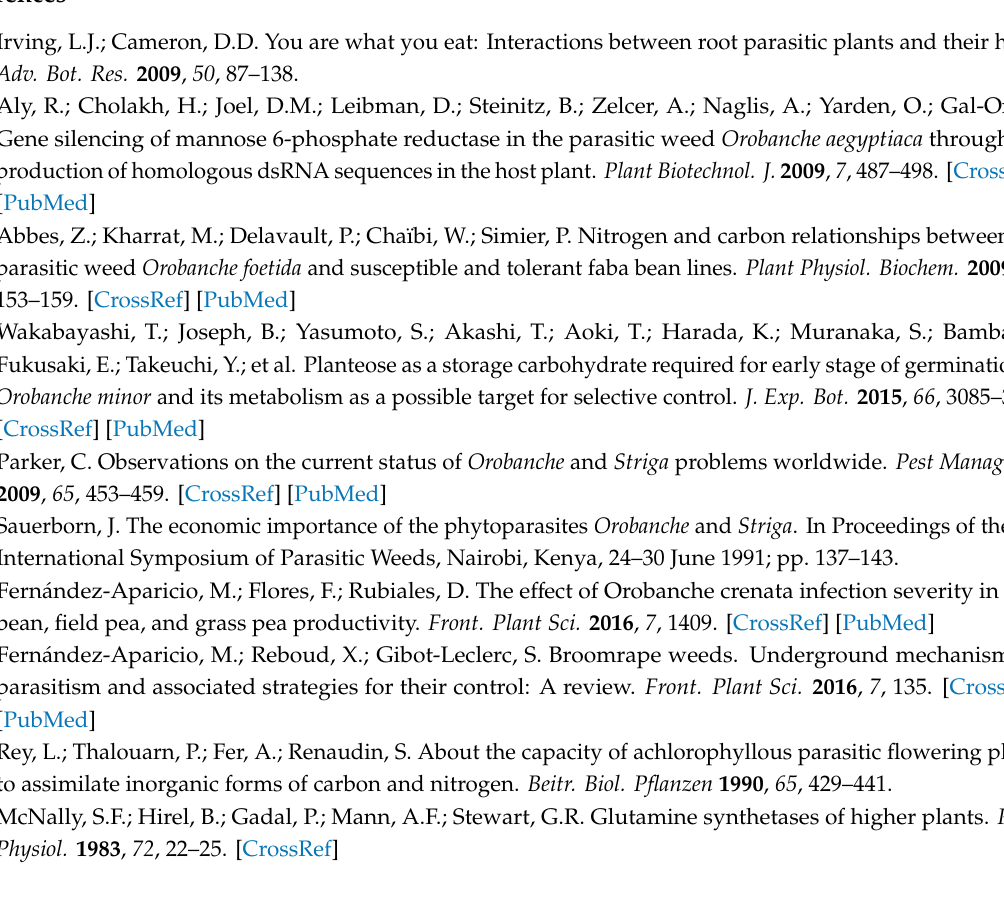
Figure S1: Histograms of p -values from analysis of variance of metabolite levels. Figure S2: Abundance of quantified metabolites and total detectable proteogenic free amino acids. Figure S3: Phylogenetic trees of asparagine synthase and aspartate amino transferase homologs. Table S1: Analysis of variance of metabolite levels. Table S2: Contigs used for expression analysis of two amino acid metabolism genes. Table S3: Metabolite profiling